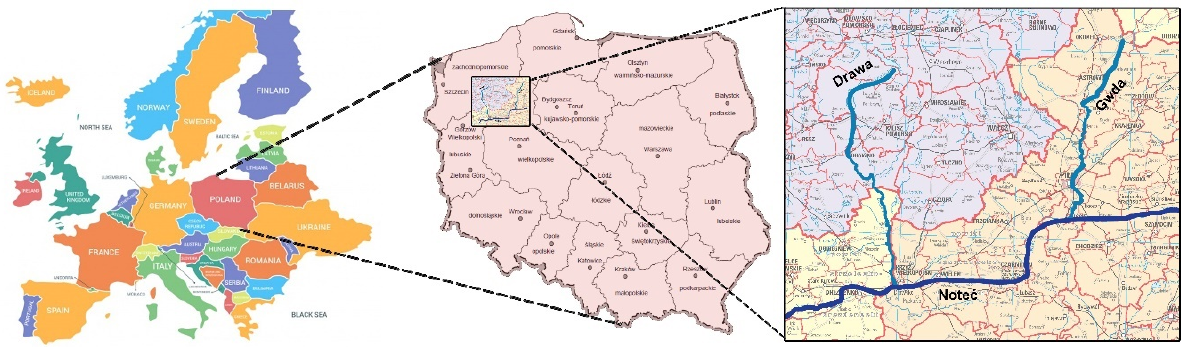
Figure 1. Location of the Wa ł cz Lake District. Source: own study.